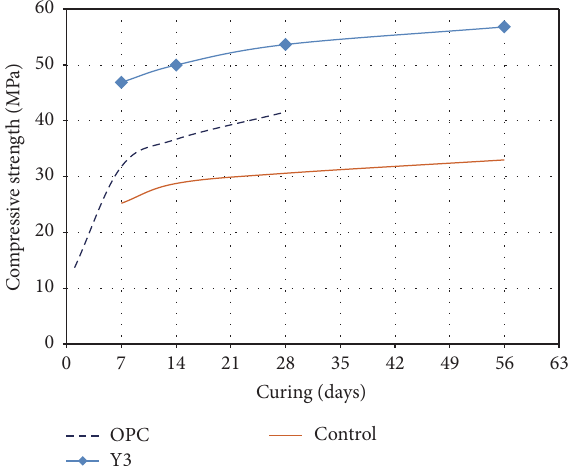
Figure 3: Comparison of compressive strength for hybrid fiber mix Y3 and control mix with compressive strength of OPC from C¸olak